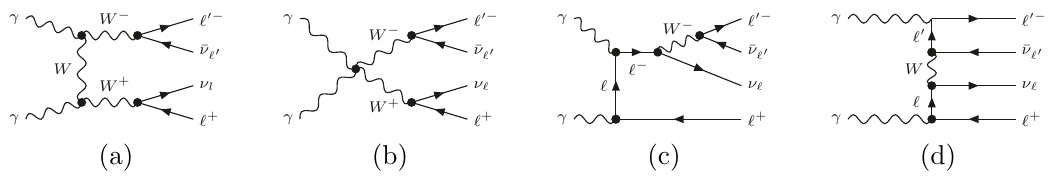
Figure 3 . Sample of photon-induced Born diagrams contributing to 2 ‘ 2 (cid:23) production in the di(cid:11)erent-(cid:13)avour case ( ‘ = ‘ 0 ) and in the same-(cid:13)avour case ( ‘ = ‘ 0 ). Double-resonant (a,b), single- 6 resonant (c) and non-resonant (d) diagrams are shown.